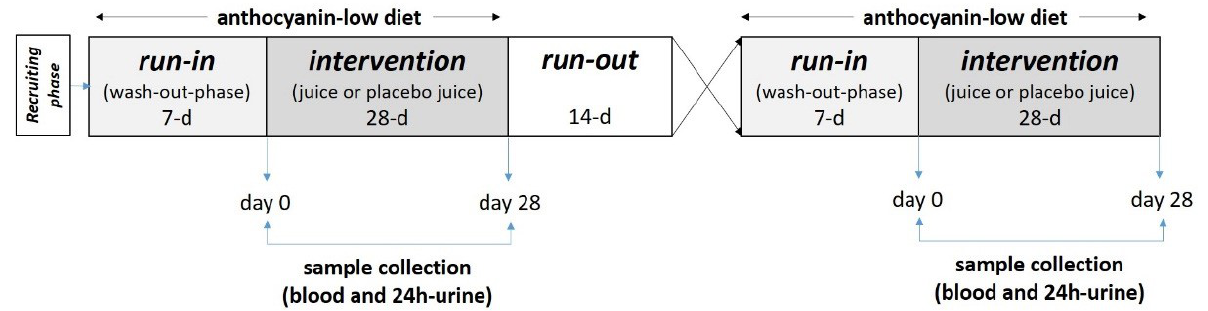
Figure 1. Study design of the ATTACH study. Participants consume the anthocyanin-rich juice and the anthocyanin-depleted placebo. Before (day 0) and after each intervention (day 28), blood and 24 h-urine samples were collected and processed for biochemical analyses ( n = 35). d, day. As phenolic compounds including anthocyanins are present in many foodstuffs and beverages, participants were explicitly counseled prior to the start of the study to fol- low a low phenolic/anthocyanin diet during the run-in and intervention period to avoid possible effects of other phenolics, especially anthocyanins, from the diet. Similar to our ANTHONIA study, the volunteers received a list of categorizing foodstuffs including bev- erages into “quantitatively limited” and “not being allowed” with slight modifications